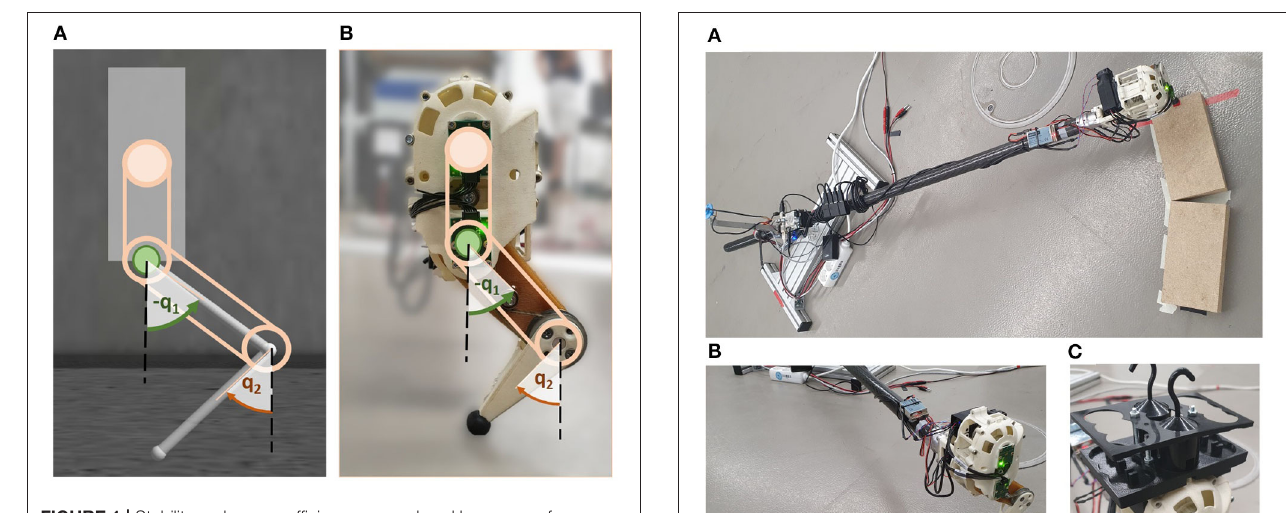
FIGURE 1 | Stability and energy efficiency are analyzed by means of a biomimetic robotic hopper in simulation (A) and hardware (B) . The hopper consists of a floating base with two links connected by compliant joints. The hip ( q 1 ) and knee joint ( q 2 ) are independently driven by series elastic actuators, implying that the rotation of either joint does not affect the other joint. The beige circle indicates the knee motor location, the green one the hip motor. Angles are defined clockwise relative to vertically extended links.